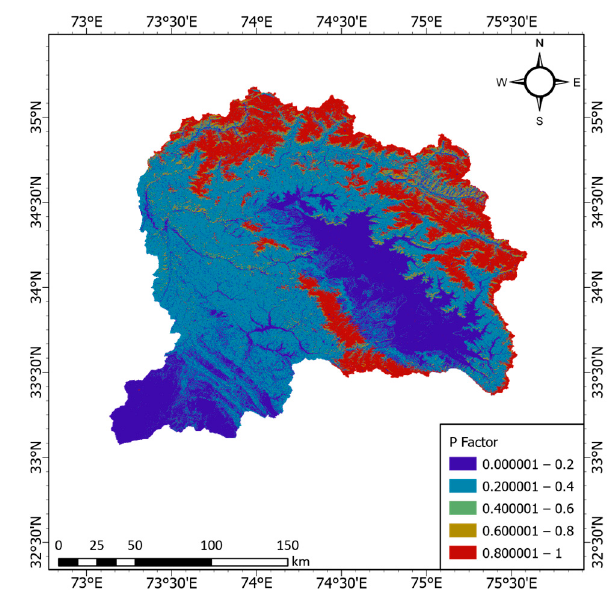
Figure 7. The conservation practice (P-factor).